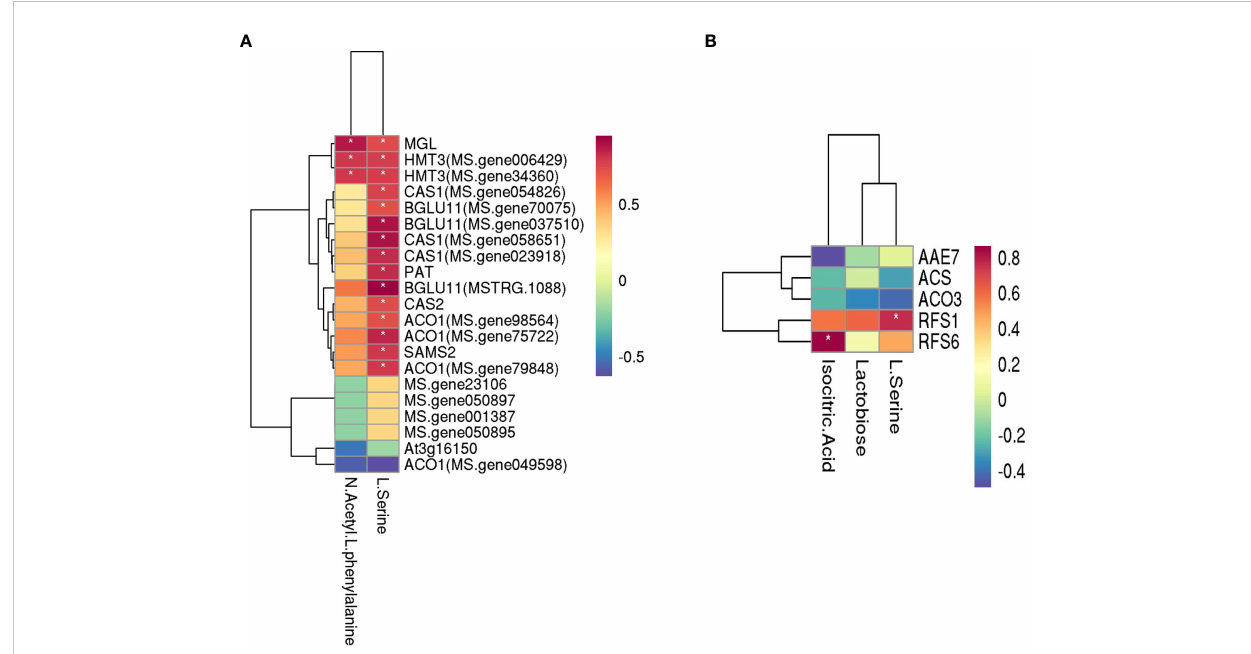
FIGURE 8 Heatmaps of amino acid metabolism and carbohydrate metabolism with the genes of three P comparison group units. (A) Amino acid metabolism and (B) carbohydrate metabolism. The darker the color (red or blue), the stronger the correlation. * means that the correlation between metabolite and gene was signi fi